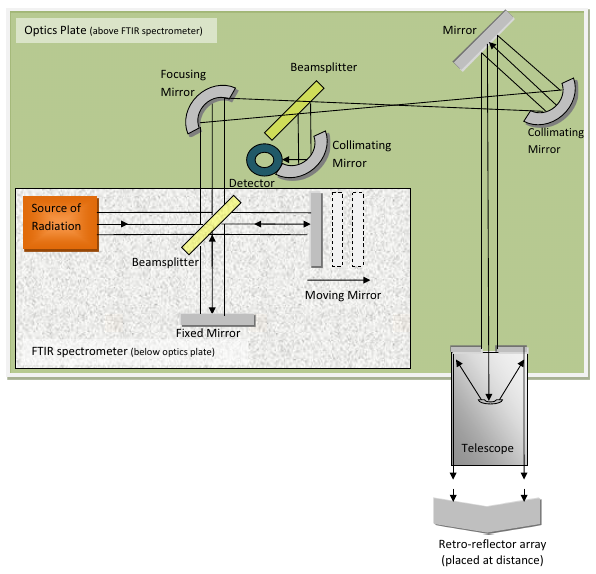
Figure 1. Schematic of the instrumental set-up, showing a basic Fourier transform spectrometer and the optics mounted on the top plate to steer the modulated radiation from the spectrometer through the telescope to the distant retro-reflector array and back again to be focused onto the